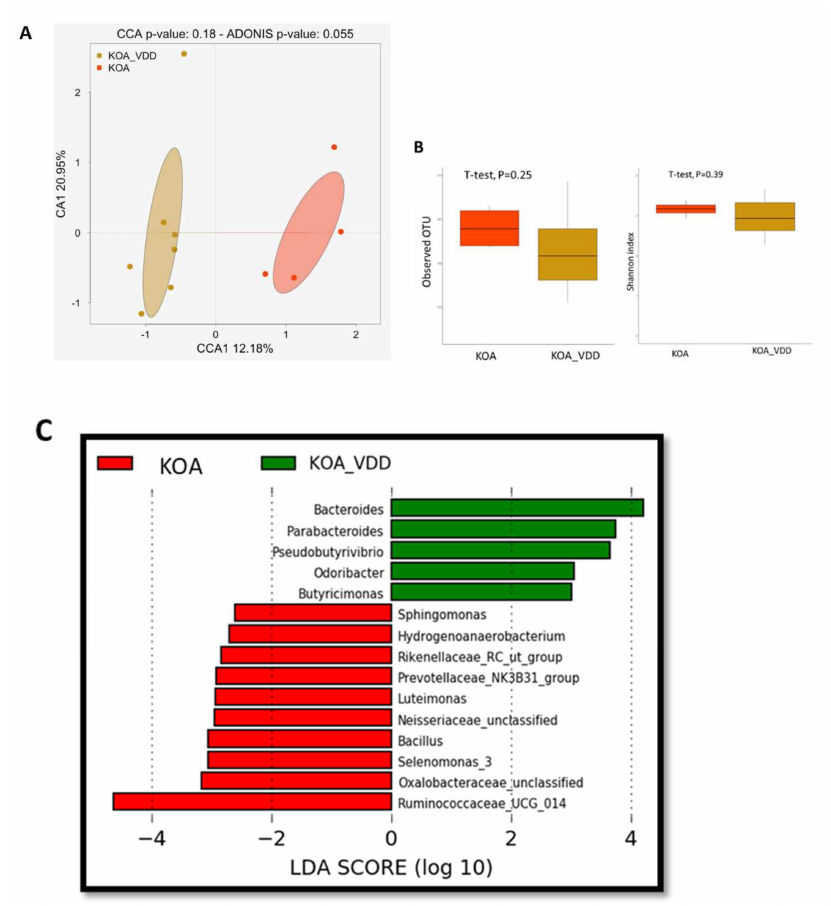
Figure 4. Effect of vitamin D deficiency on Knee osteoarthritis-associated dysbiosis: ( A ) canonical correspondence analysis (CCA) was performed to study the beta diversity between stool microbiome in KOA_VDD and KOA patients; ( B ) Alpha-diversity using the observed OTU and Shannon index based on Bray–Curtis distances; ( C ) A histogram of the log 10 transformed LDA scores was computed for features that showed differential abundance between KOA_VDD and KOA_NVD